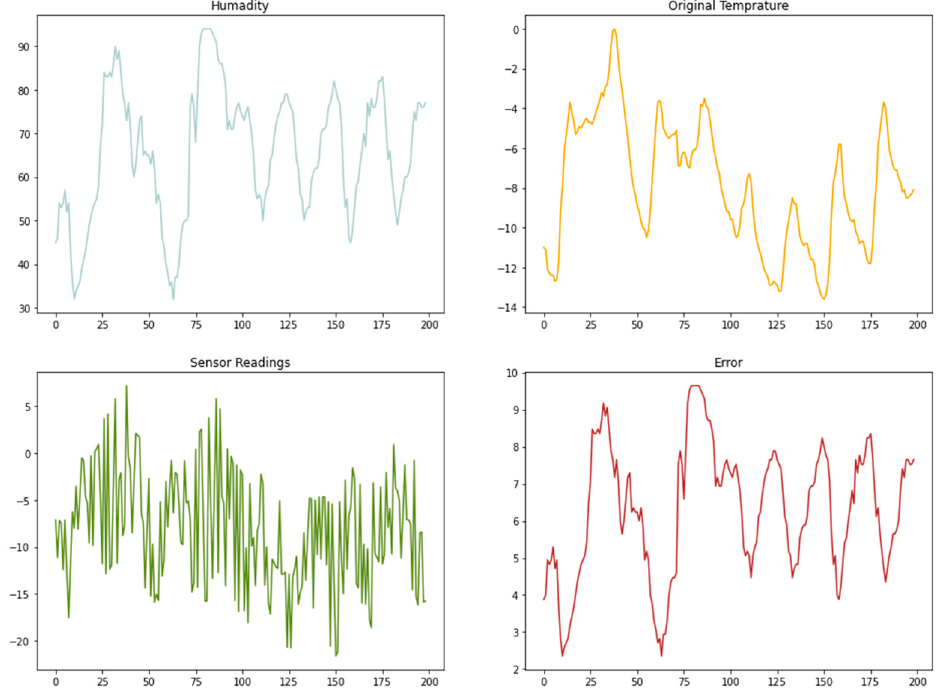
Figure 6. Representation of humidity, sensor readings, temperature, and error.